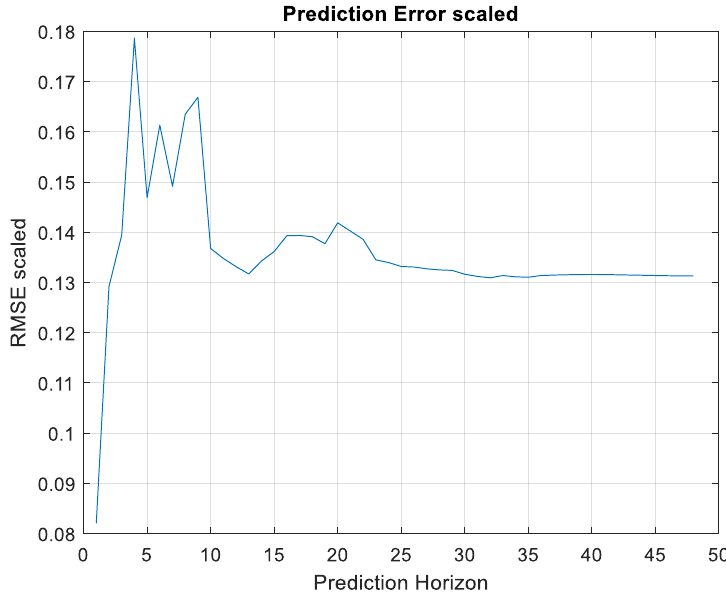
Figure 7. RMSEs of the scaled air temperature within the prediction horizon.